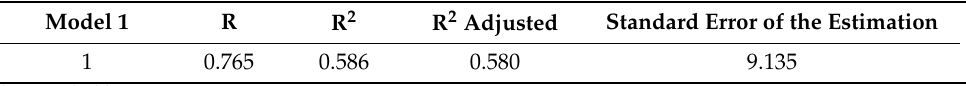
Table 3. Google Scholar h-index Regression Statistics (Model